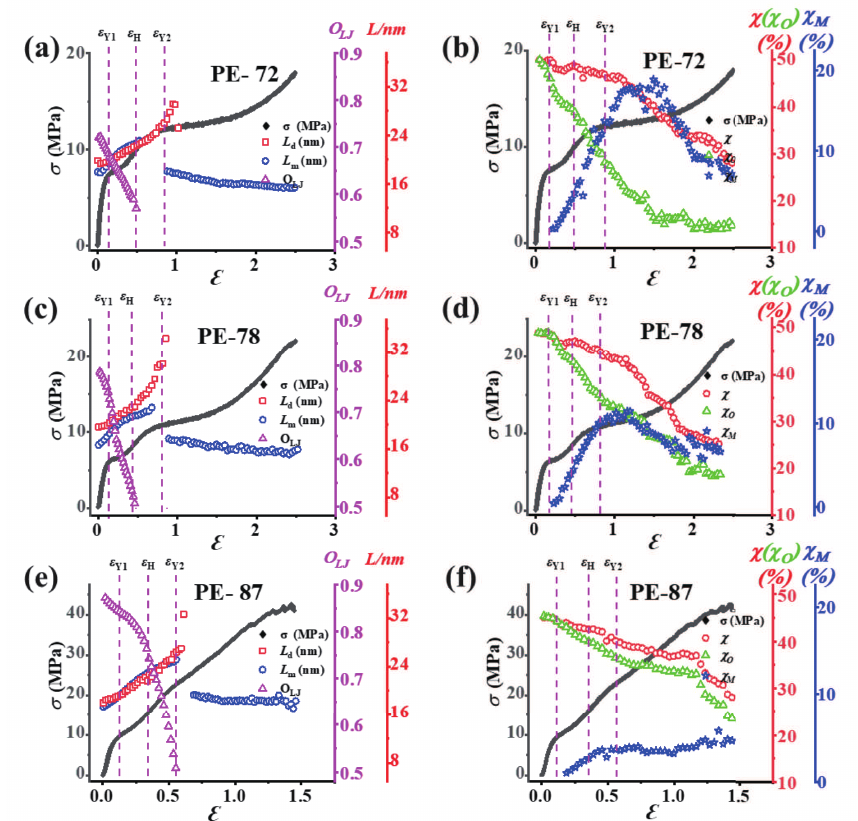
Figure 5. The long periods along the meridian and diagonal direction and the Hermans’ orientation factor for ( a ) PE-72, ( c ) PE-78, and ( e ) PE-87 films. The total crystallinity and the relative contents of the monoclinic and orthorhombic phases for ( b ) PE-72, ( d ) PE-78, and ( f ) PE-87